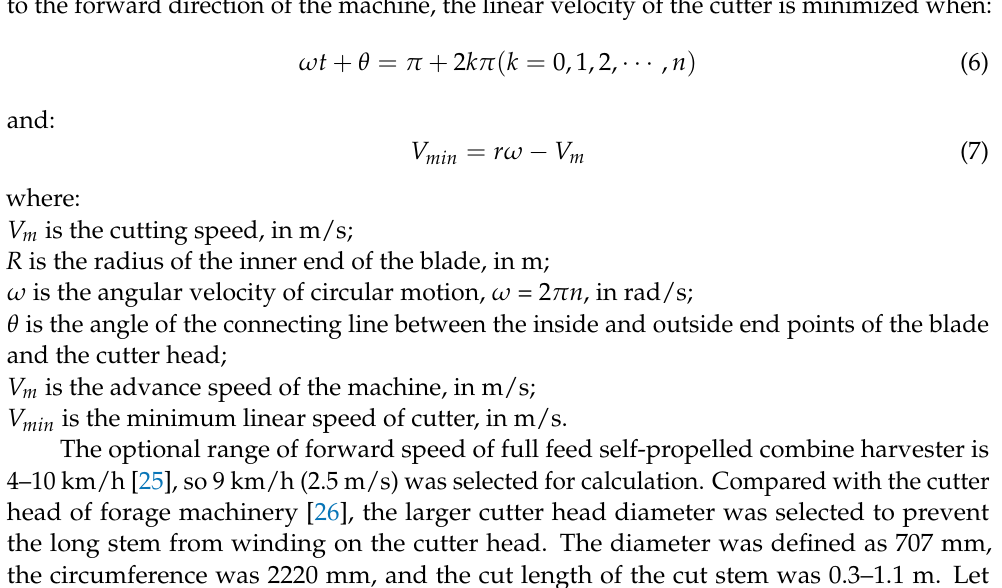
Figure 8. Blade Figure 8. Blade trajectory.